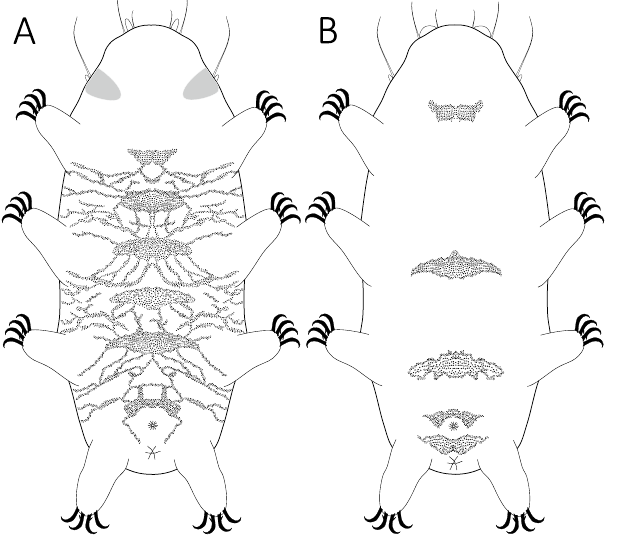
Figure 5. Two general ventral ornamentation patterns found within Pseudechiniscus : ( A ) complex ( Pseudechiniscus (M). cf. angelusalas ), ( B ) reduced ( Pseudechiniscus (P.) sp. 9).